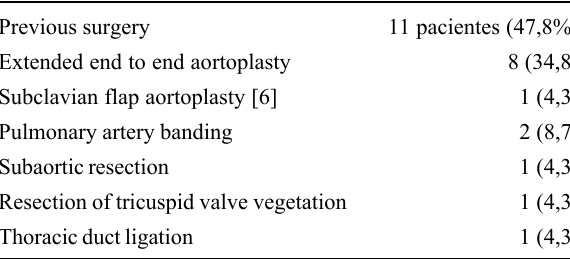
Table 3. Previous surgical procedures Previous